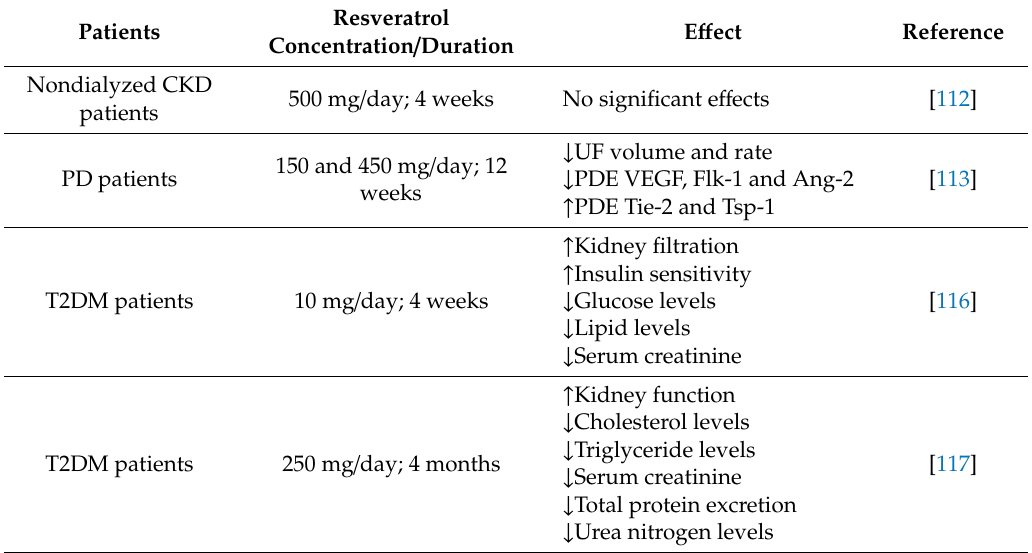
Table 9. E ff ects of resveratrol on human